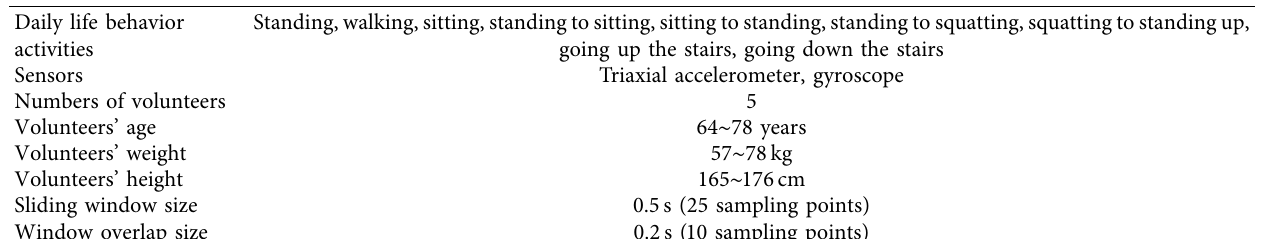
Figure 1: User interface for falling behavior recognition APP. (a) System login interface. (b) System function interface. (c) User Table 1: Basic data collection information.